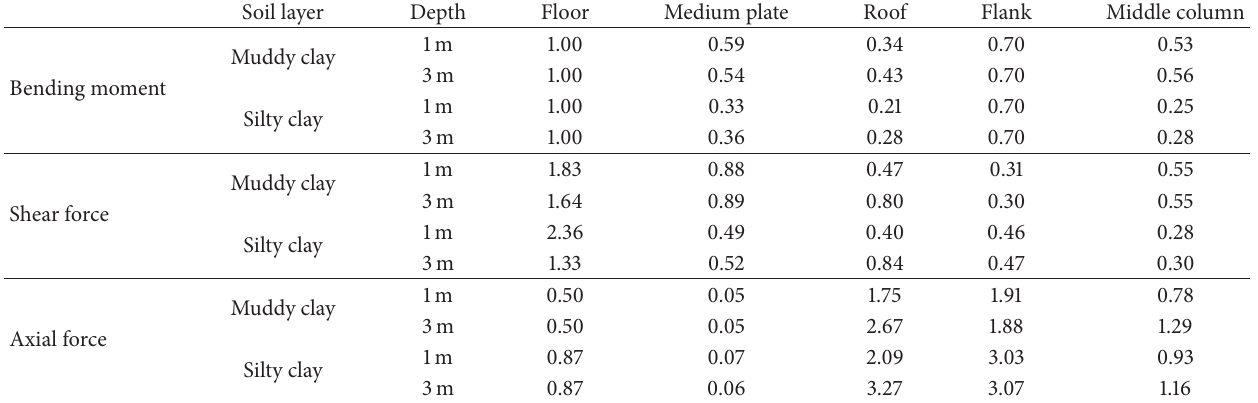
Table 4: The internal force correction coefficient by using equivalent inertial force method.